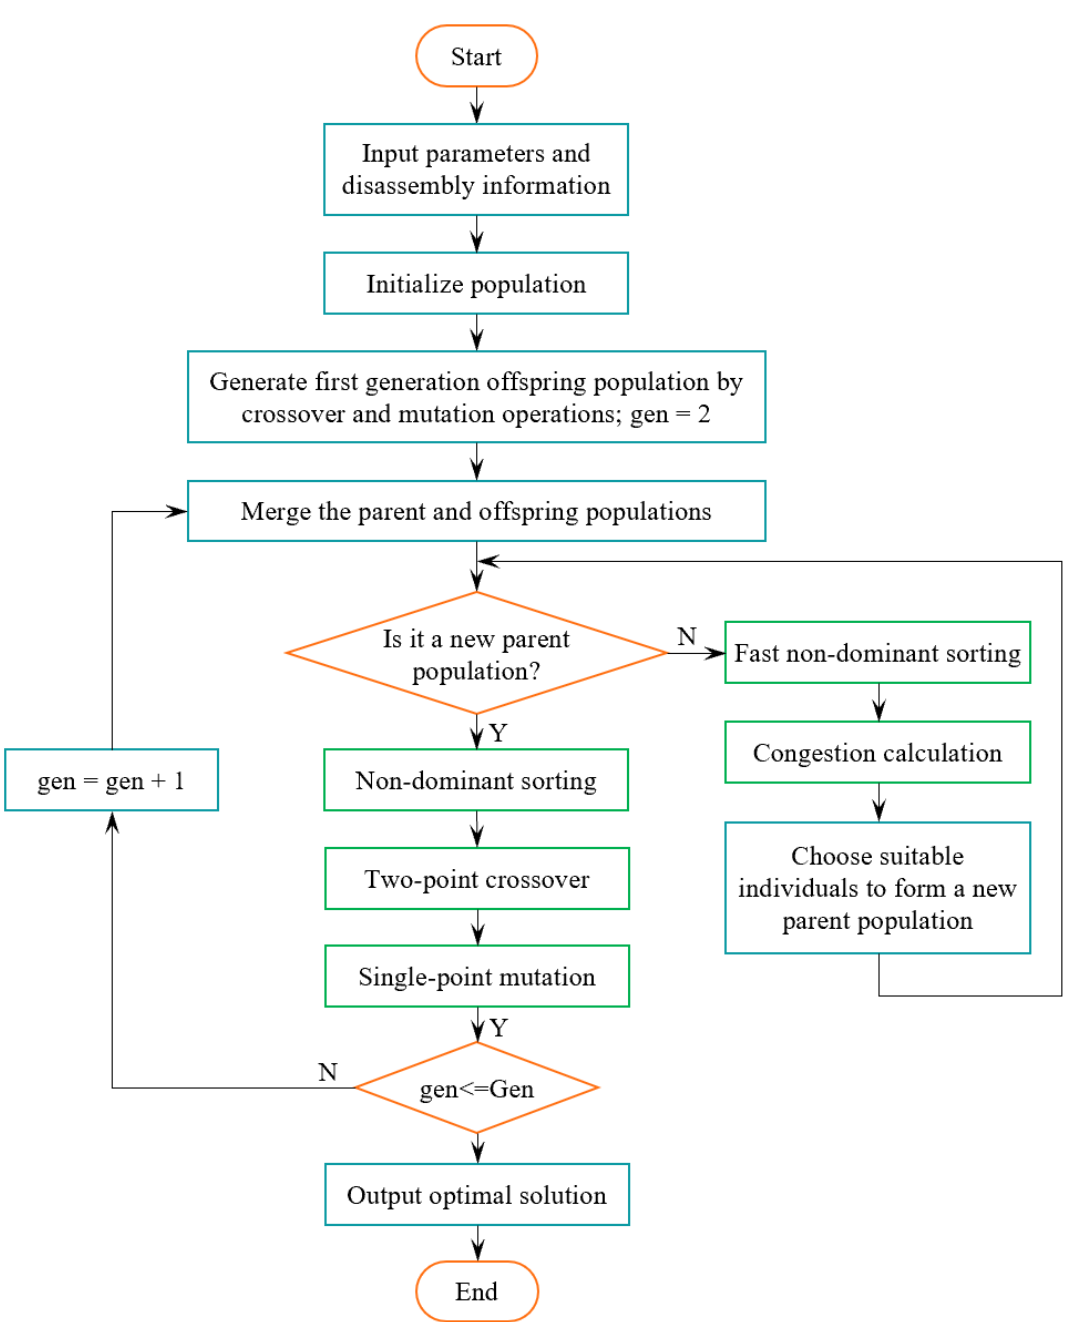
Figure 1. Flowchart of NSGA-II.